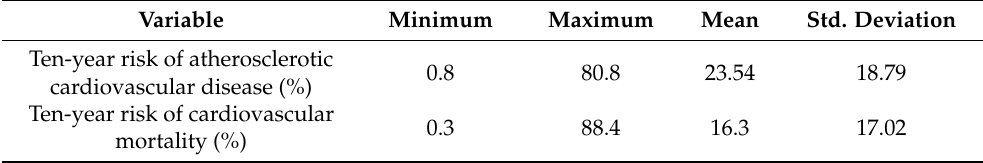
Table 2. Atherosclerotic cardiovascular disease and mortality risk scores according to CKD patch.